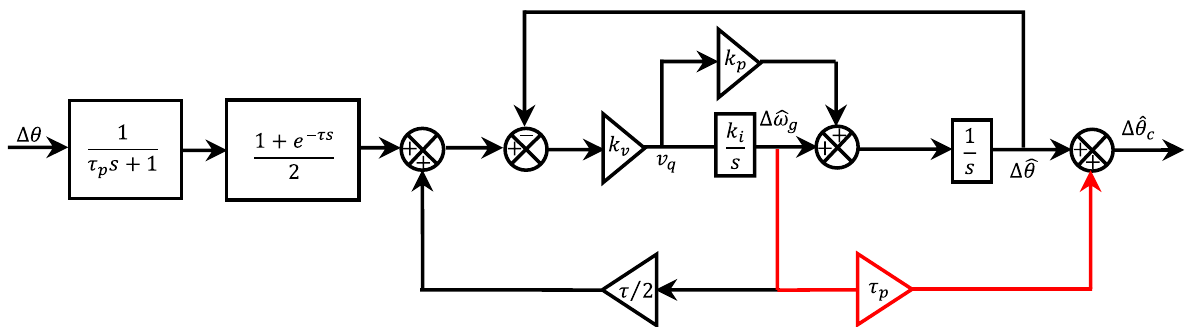
Fig. 2 The small-signal model of the proposed FFSOGI-PLL, where τ is the arbitrary time delay and τ p = 2 / k ω n is the time constant of the SOGI block